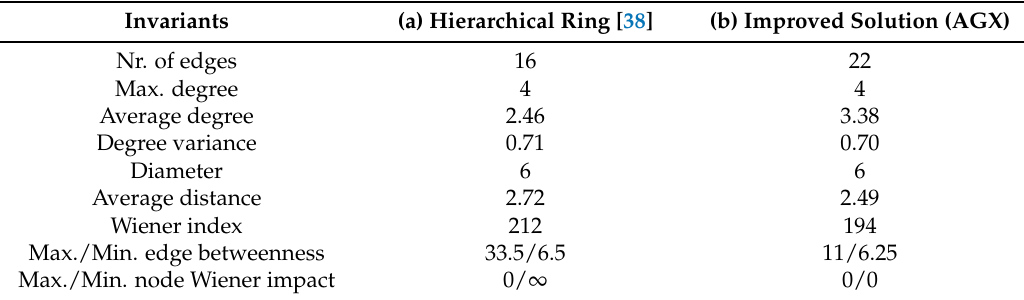
Figure 4. CRAN topologies: ( a ) hierarchical ring; and ( b ) improved solution (AGX). Table 4. CRAN topologies (13